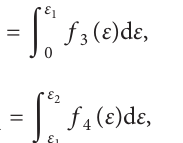
Figure 1: Stress-strain path of the SCLUC